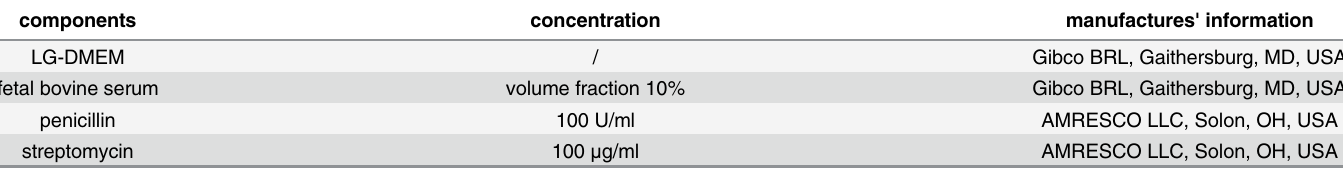
Table 1. The detailed basic culture medium component list.